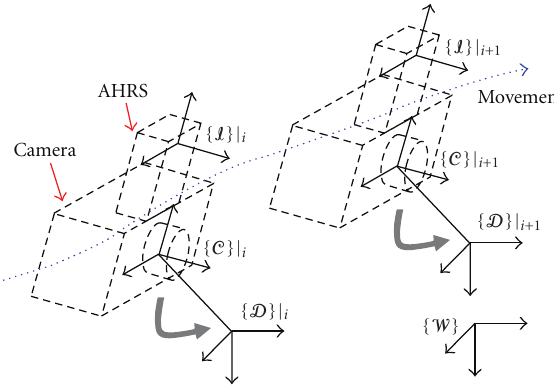
Figure 2: Moving observer and frames of